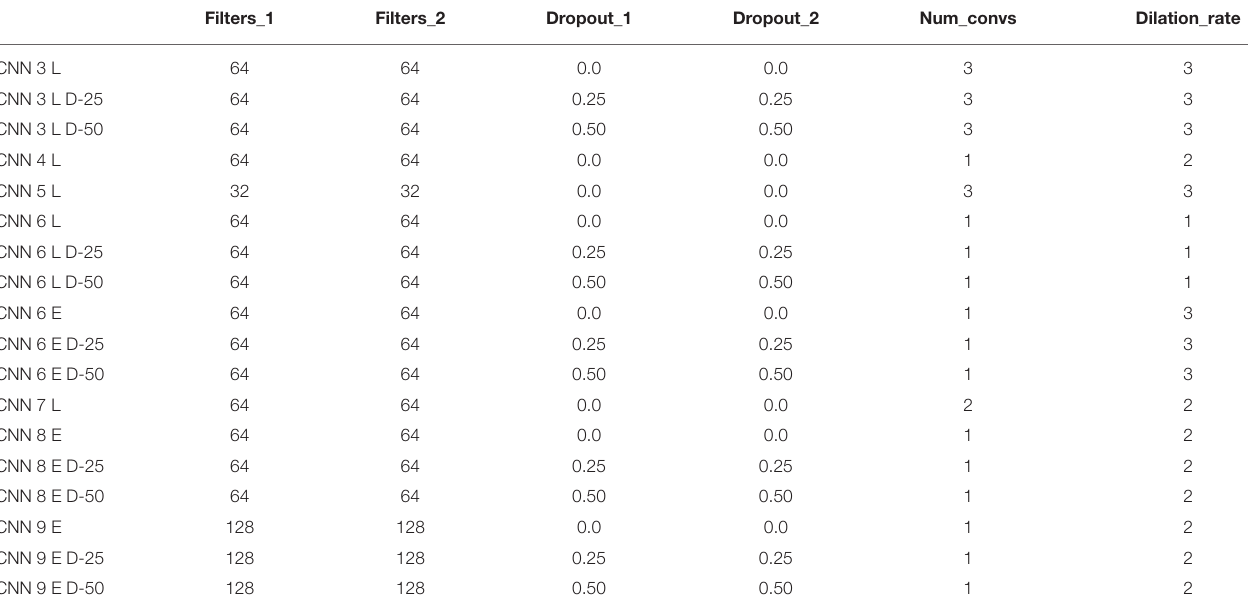
TABLE 1 | Parameters of dual-input CNN models derived from the template architecture shown in Figure 4 .